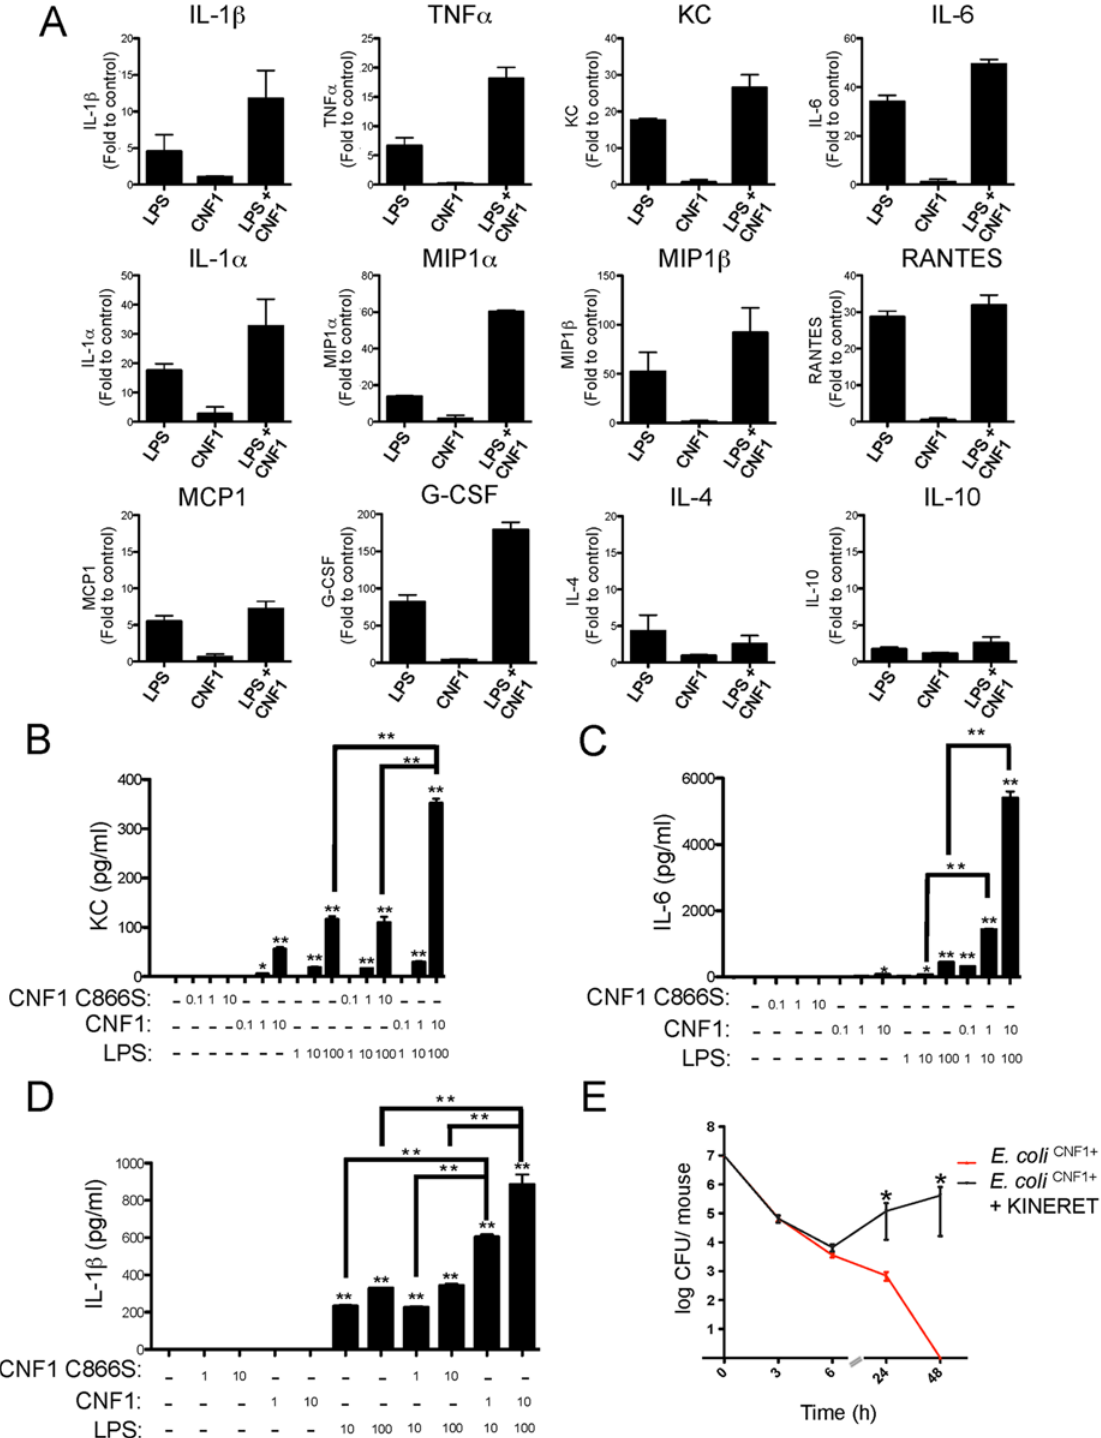
Fig 2. CNF1 potentiates LPS-triggered immune responses. (A) Monocytes (5x10 5 cells per condition) isolated from mouse blood were treated with PBS (control) or with 1 μ g/ml CNF1 toxin for 10 h with or without 100 ng/ml LPS. Cell culture supernatants were analyzed using mouse ELISArray kits (n = 3). The data are shown as fold inductions compared with the control condition. (B, C and D) Monocytes (5x10 5 cells per condition) purified from mouse blood were treated for 10 h. Cells were treated as indicated with 0.1, 1, or 10 μ g/ml of CNF1 toxin or the CNF1 mutant C866S alone or in combination with ultrapure E . coli LPS at 1, 10 or 100 ng/ml (n = 3). (B) KC, (C) IL-6, and (D) IL-1 β cytokine secretion was analyzed using ELISA (n = 4). (E) Female BALB/c mice were